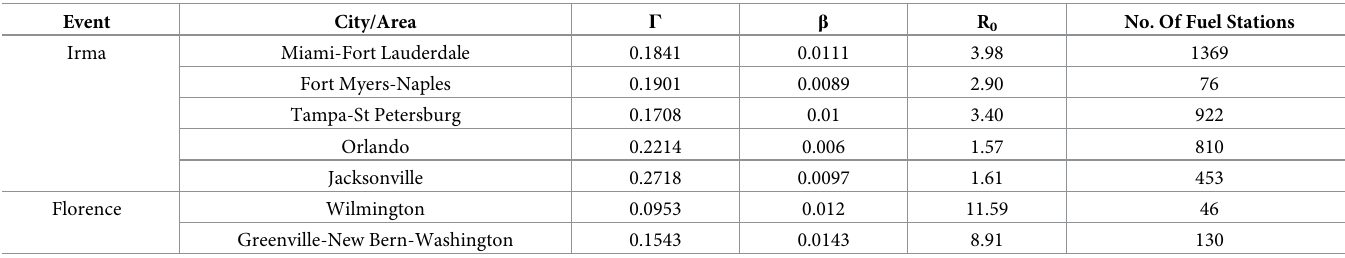
Table 2. β , γ and R 0 parameters and the number of fuel stations for the major cities affected by Hurricanes Irma and Florence.